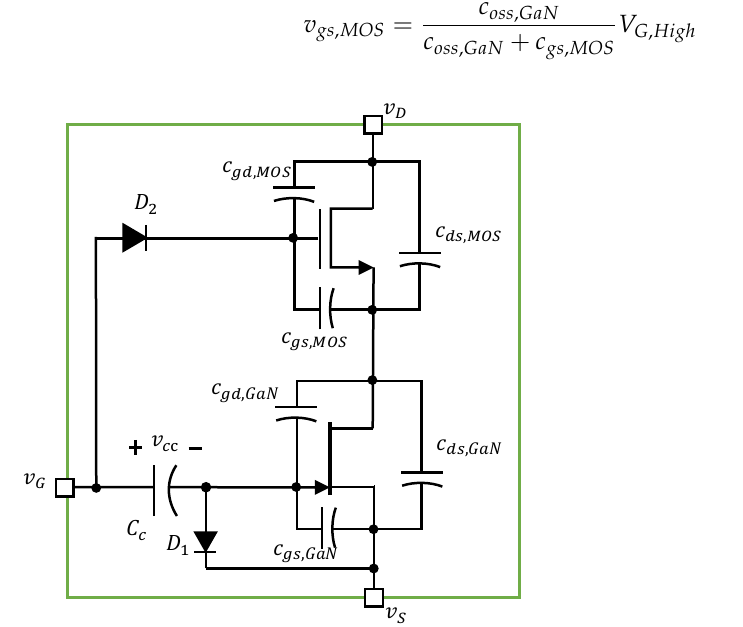
Figure 9. Type 2B—Alternative GaN-Switching Cascode GaN HEMT Power Module. Figure 9. Type 2B — Alternative GaN-Switching Cascode GaN HEMT Power Module